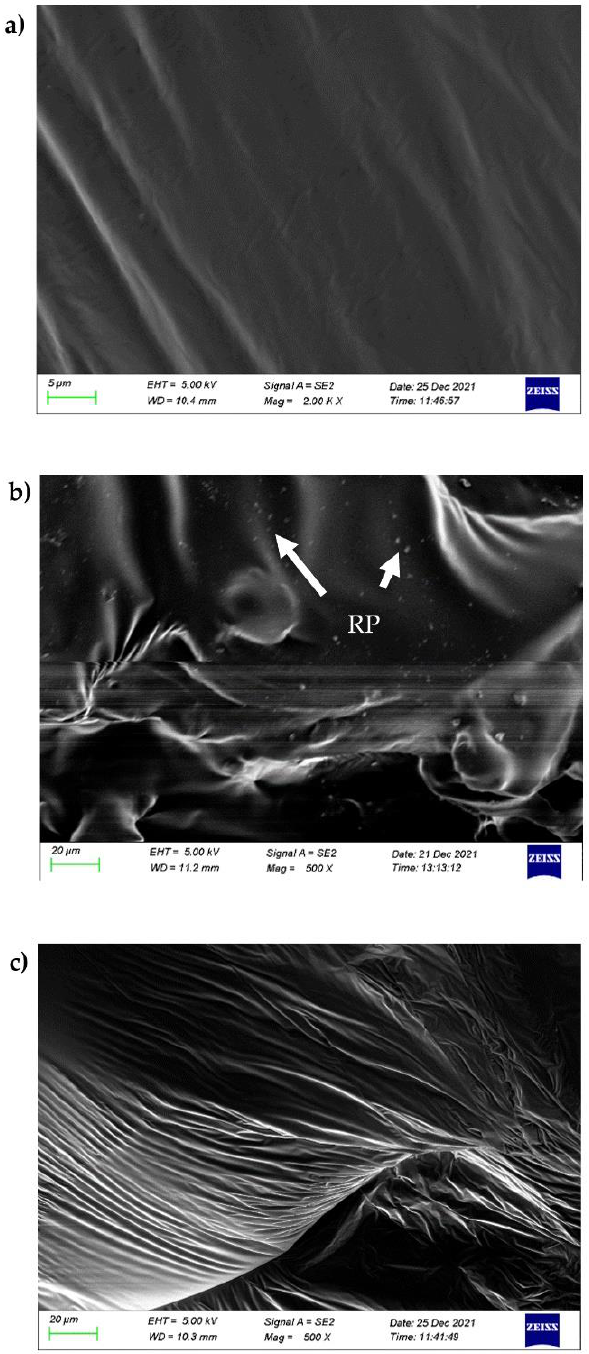
Figure 10. Micrograph of composite modified asphalt: ( a ). base asphalt scanning electron microscope; ( b ). SEM of modified asphalt by rubber powder; ( c ). SEM of GO/rubber powder composite- modified asphalt.